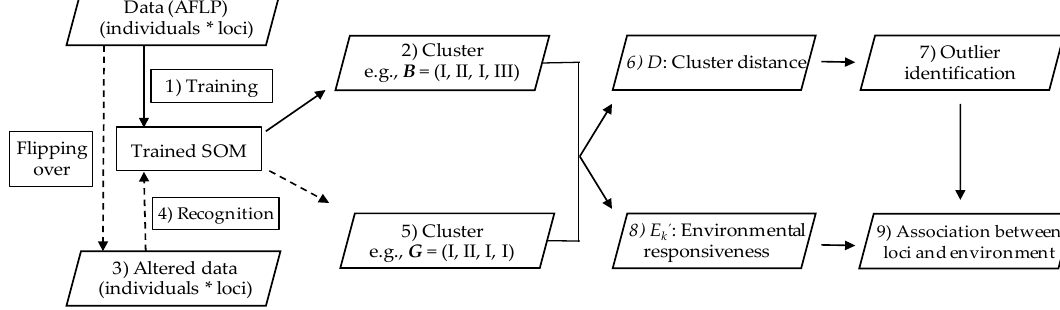
Figure 2. Flowchart for determining outlier loci and environmental responsiveness based on SOM sensitivity test through training and recognition. The numbers 1) to 9) show the processes described in Section 2.